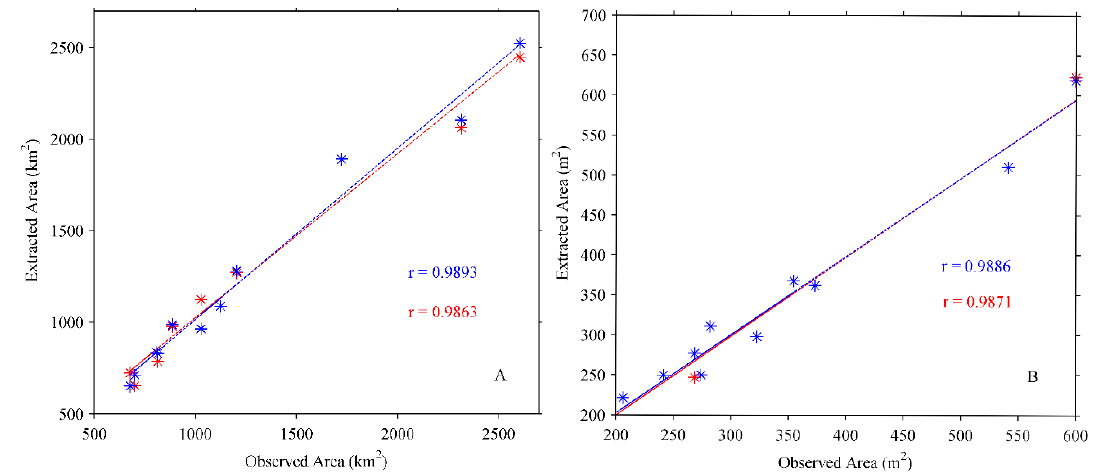
Figure 3. Comparison between the extracted and observed areas (( A )—water area, ( B )—algal bloom area). (Blue-extraction results from the traditional methods optimized by the DL-NN; red-extraction results from the traditional methods; the extracted area refers to the extraction results from the MODIS images; observed area refers to the corresponding the extraction results from the Landsat images).